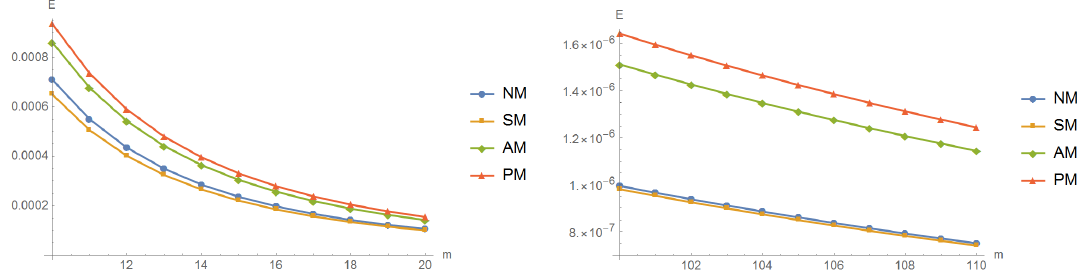
Figure 1. The comparison of flops-like efficiency indices for various schemes with and without memory by changing m